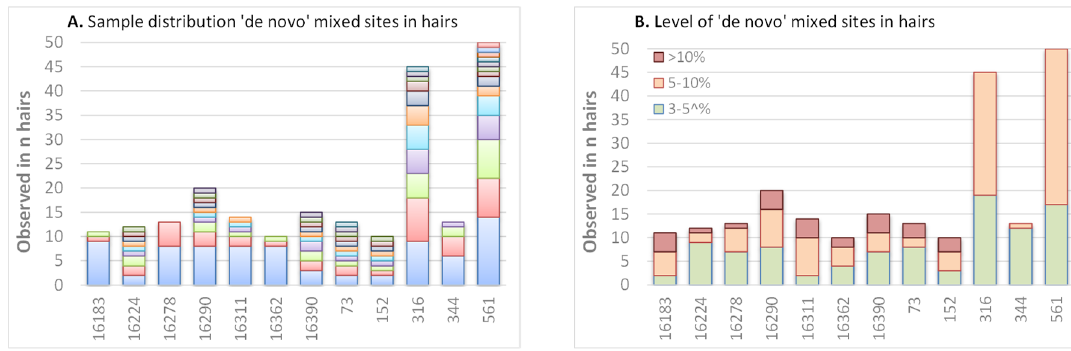
Figure 5. Top positions (observed in ≥ 10 hairs) for which mixed sites were observed in hairs but not in the corresponding buccal reference. ( A ) Distribution over different individuals, ordered by most frequent individual at the bottom to least frequent individual at the top (samples ordered per site by frequency: the same sample can have a different colour for different sites). ( B ) Distribution for various categories of mixed level.